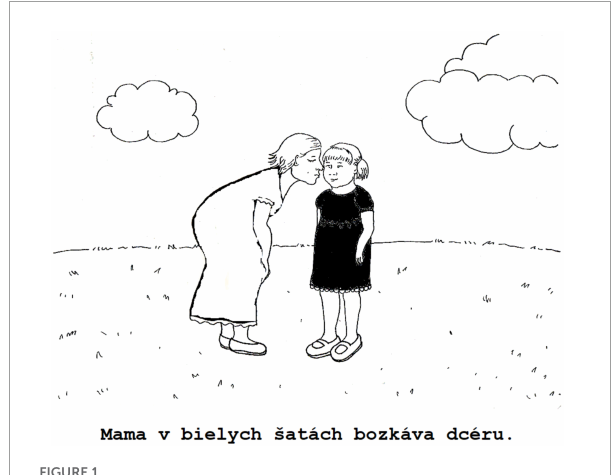
FIGURE1 Test of sentence comprehension, sample picture,